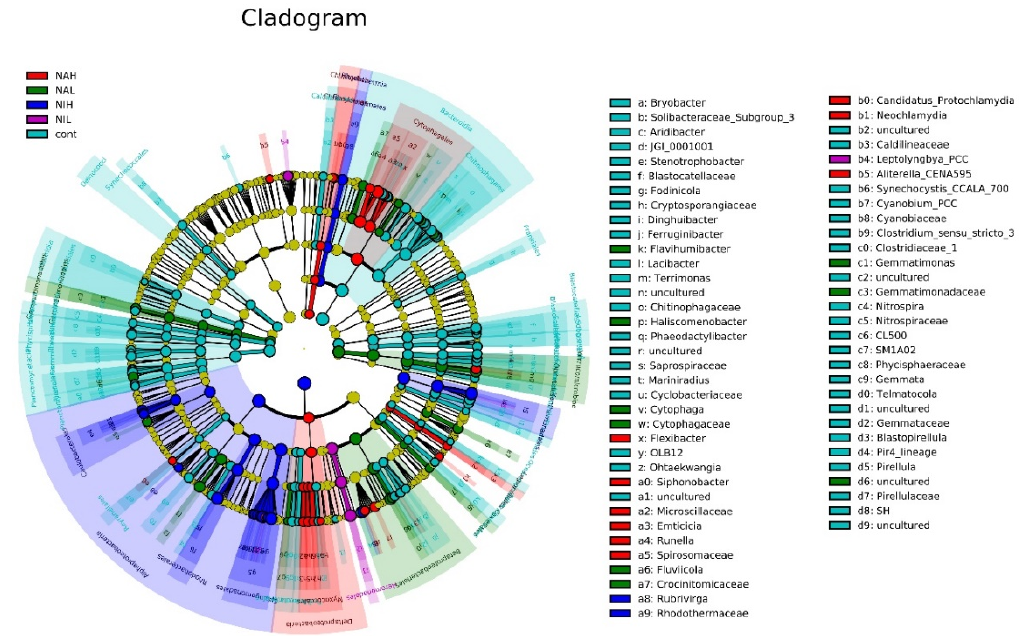
Figure 5. Diagram of species evolution from phylum to genus in the five treatments. The circles radiating from the inside to the outside represent the taxonomic levels from phylum to genus. Each node at a different taxonomic level represents a taxon of a species at that level, and the higher the species abundance, the larger the node is. Cont: control; NAH: 1 mg/L sodium selenate); NAL: 100 µg/L sodium selenate; NIH: 1 mg/L sodium selenite; NIL: 100 µg/L sodium selenite. The results showed that Spirosomaceae had a high relative abundance in the NAH group, and Gemmatimonas had a higher relative abundance in the NAL group, producing